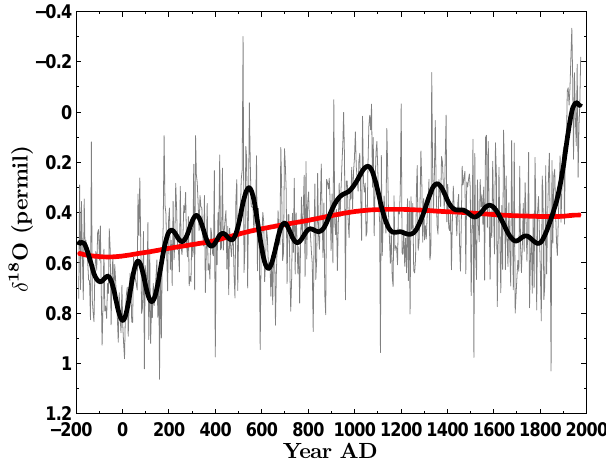
Fig. 2. Significant oscillatory components in the δ 18 O series of core GT90/3, obtained by SSA with a window width of M ≈ 600 yr; only the oscillations within the centennial range are plotted here. They correspond to RCs 2–3, 4–5, 6–7–8 and 9–10, respectively.